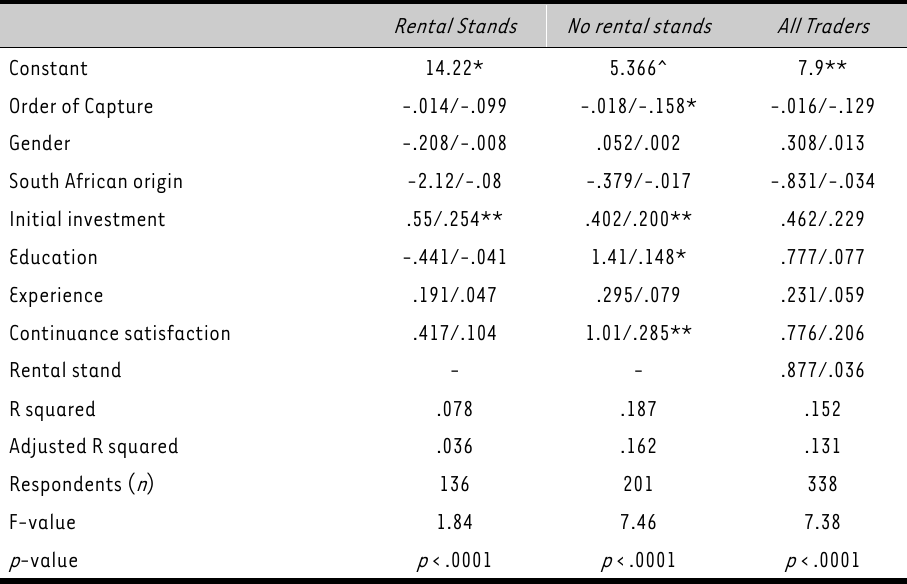
TABLE 4: Multiple Linear Regression Results, 2008 Rental Stands No rental